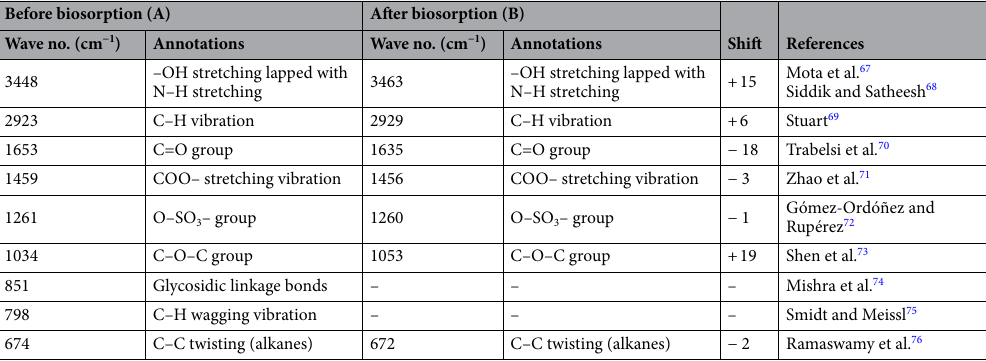
Before biosorption (A) After biosorption (B)